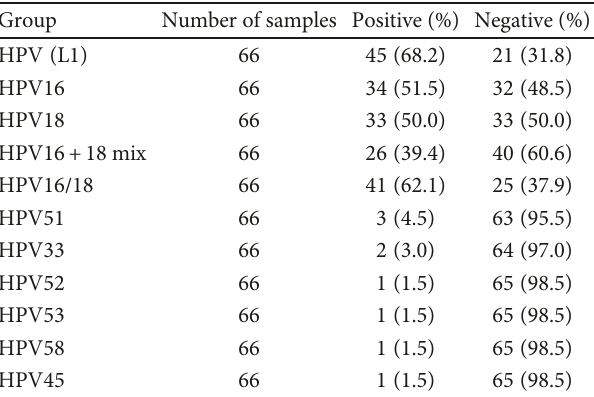
Table 3: HPV detection in esophageal cancer tissue samples.